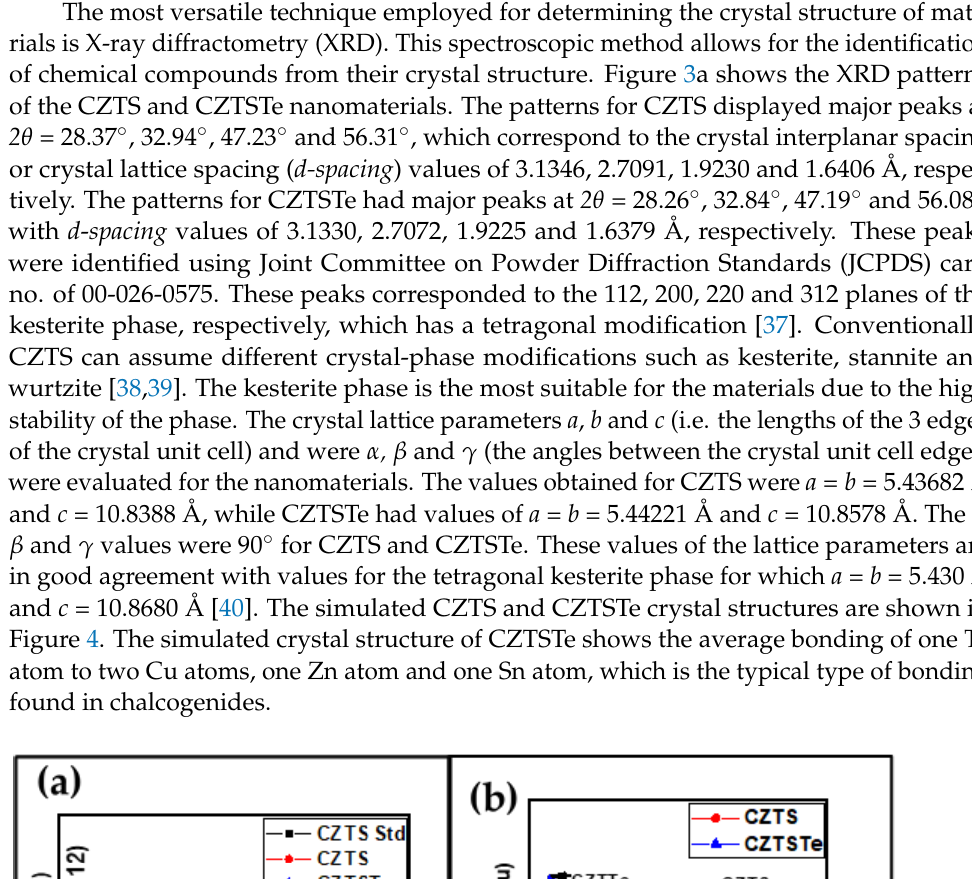
Figure 4. Simulated crystal structures of ( a ) CZTS and ( b ) CZTSTe (blue = Cu; green = Sn; pink = Zn; red = Te; yellow = S). Table 1. Crystal parameters. Material